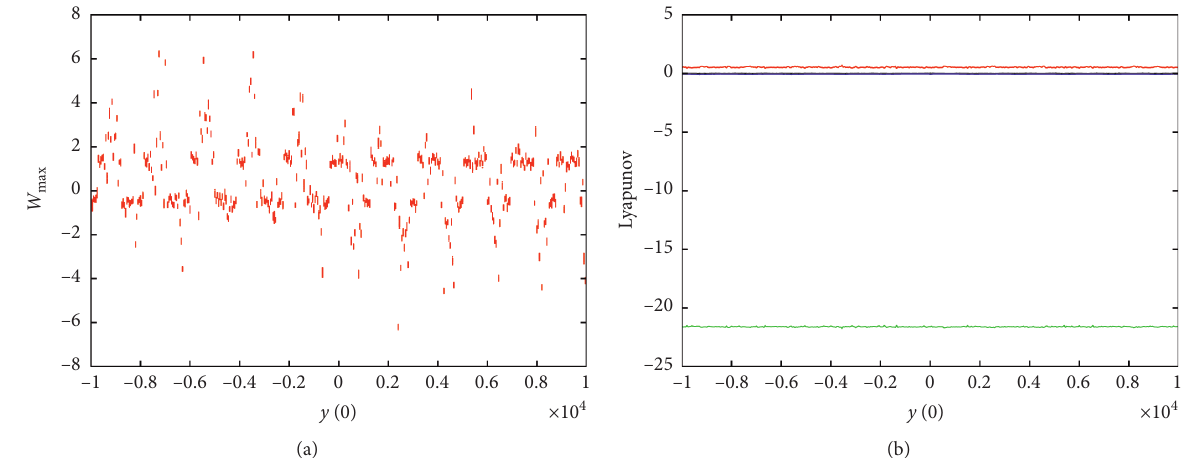
Figure 10: (a) Bifurcation diagram of the state variable w and (b) Lyapunov spectrum with respect to initial condition y ( 0 ) in the region [− 10 4 , 10 4 ] .